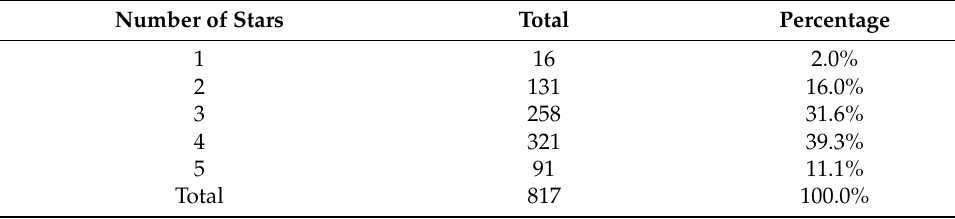
Table 7. Hotel companies based on the number of